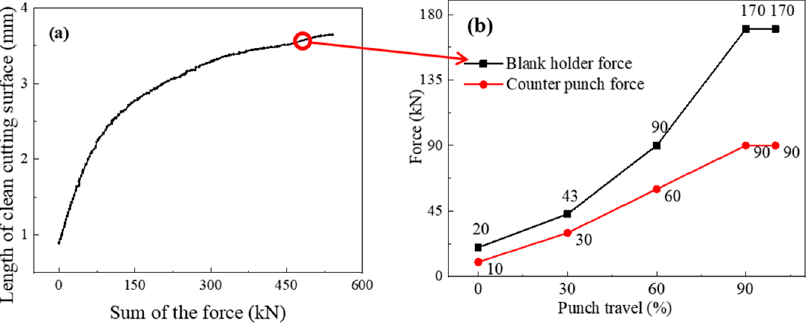
Figure 10. Pareto front and load route: ( a ) Pareto front; ( b ) the loading route represented by the points on the curve.